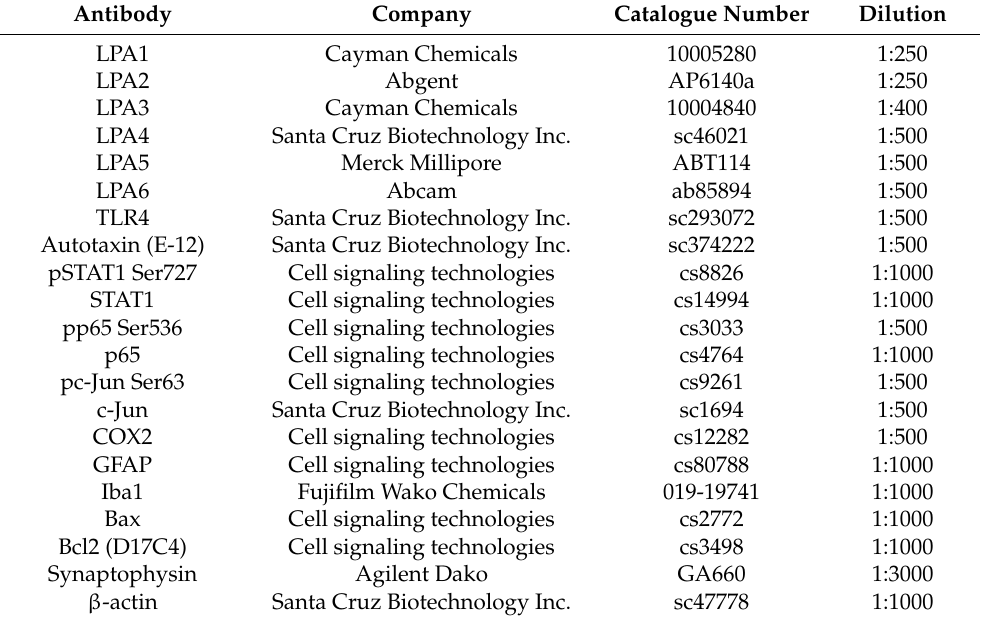
Table 1. Suppliers and dilution of antibodies used in immunoblotting experiments.